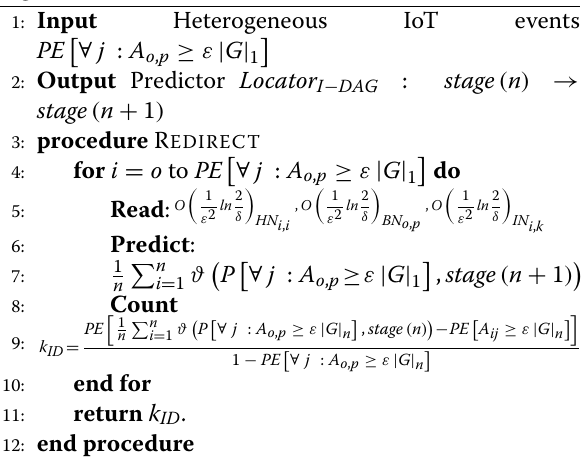
Algorithm 2 I-DAG workflow locator Locator I − DAG